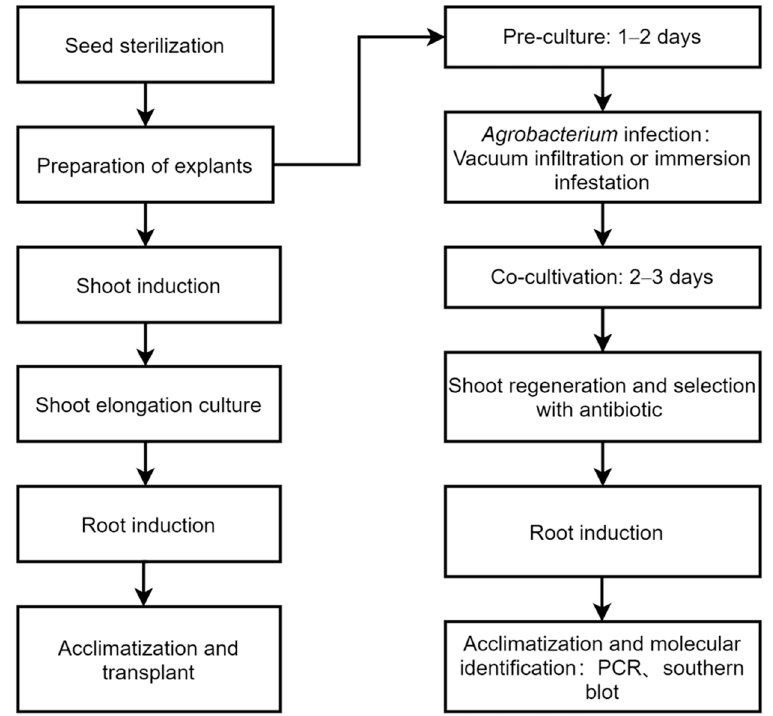
Figure 2. The protocol of in vitro regeneration ( left ) and Agrobacterium -mediated transformation ( right ).